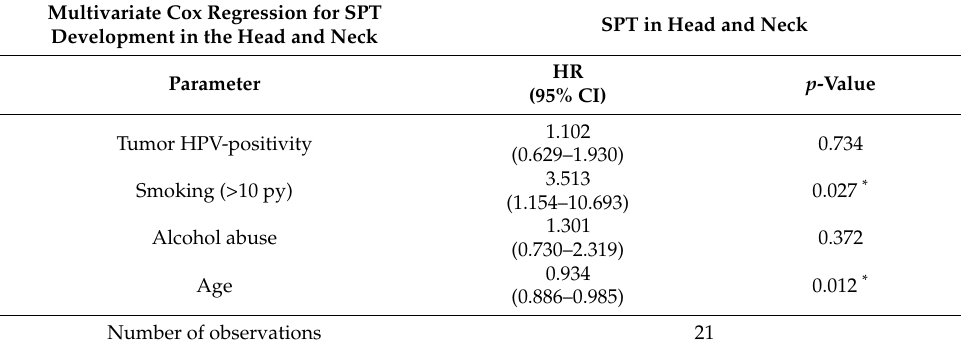
Table 8. Multivariate Cox regression for SPT development in the head and neck area. Table 8 describes the results of the multivariate Cox regression of all SPT with respect to localization in the head and neck area (0 = SPT outside head and neck, 1 = SPT in head and neck) regressed on the independent variables tumor HPV positivity (negative = 0, positive = 1), smoking status (0 = <10 py, 1 = ≥ 10 py), alcohol status (0 = no alcohol abuse, 1 = alcohol abuse), and age (in years). * indicates statistical significance at the 5% significance level. Abbreviations: CI = confidence interval, HR = hazard ratio, py = pack years. Multivariate Cox Regression for SPT Development in the Head and